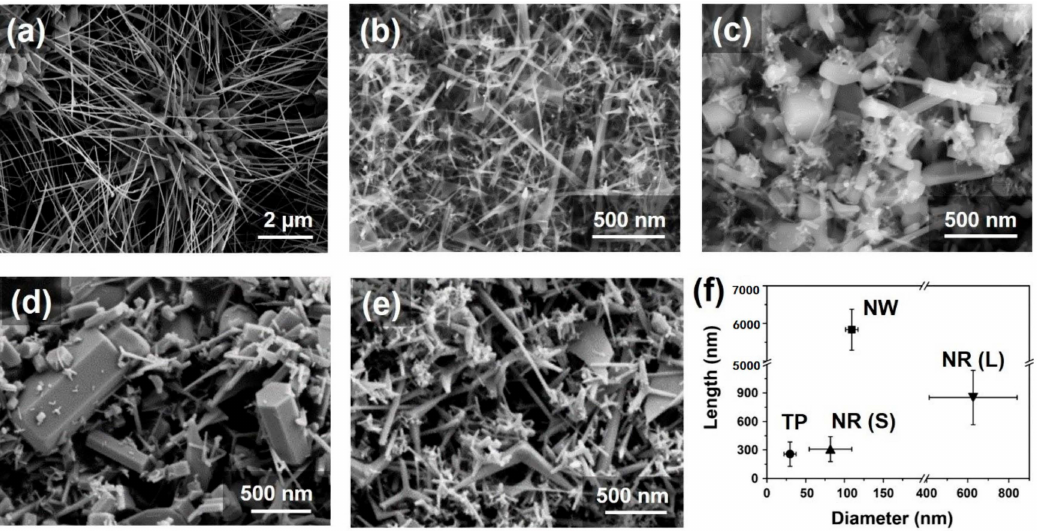
Figure 3. SEM images of synthesized ZnO nanomaterials using ( a ), ( b ) compressed air, ( c ) high-purity air, ( d ) O 2 , and ( e ) O 2 / N 2 mixed gas. ( f ) Diagram shows length versus diameter of synthesized ZnO nanomaterials (NW; nanowire, TP; tetrapod, and NR (S), (L); small and large nanorod). Table 1. Morphology, ratio, and size of synthesized ZnO nanomaterials depending on the type of plasma